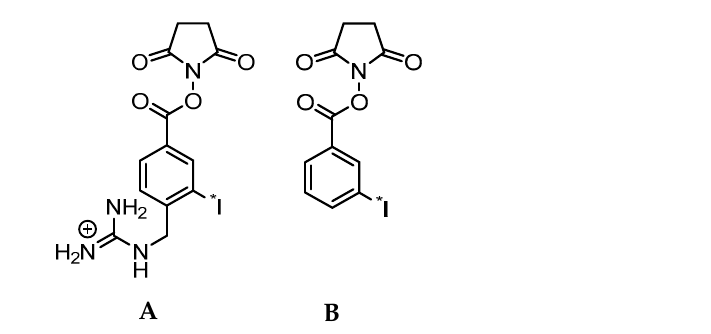
Figure 1. Chemical structures of the N -succinimidyl ester acylation agents [*I]SGMIB ( A ) and [*I]SIB ( B ).